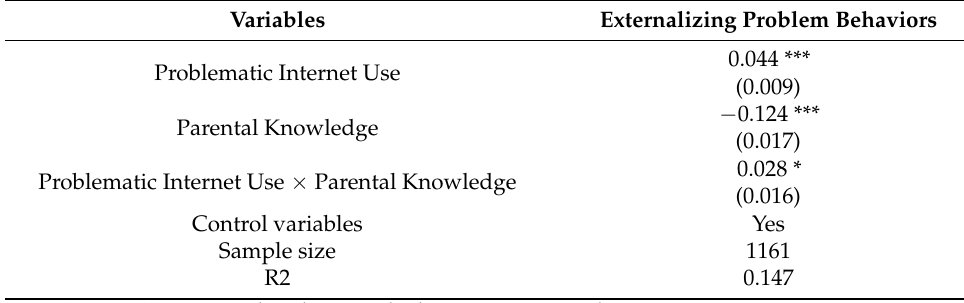
Table 4. Moderated regression analyses predicating rural adolescent externalizing problem